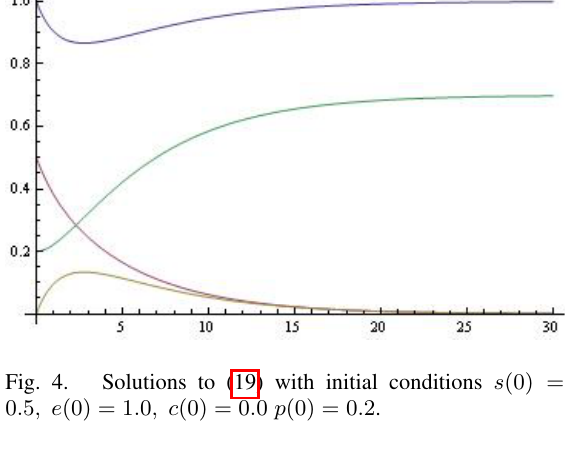
Fig. 4. Solutions to (19) with initial conditions s (0) = 0 . 5 , e (0) = 1 . 0 , c (0) = 0 . 0 p (0) = 0 . 2